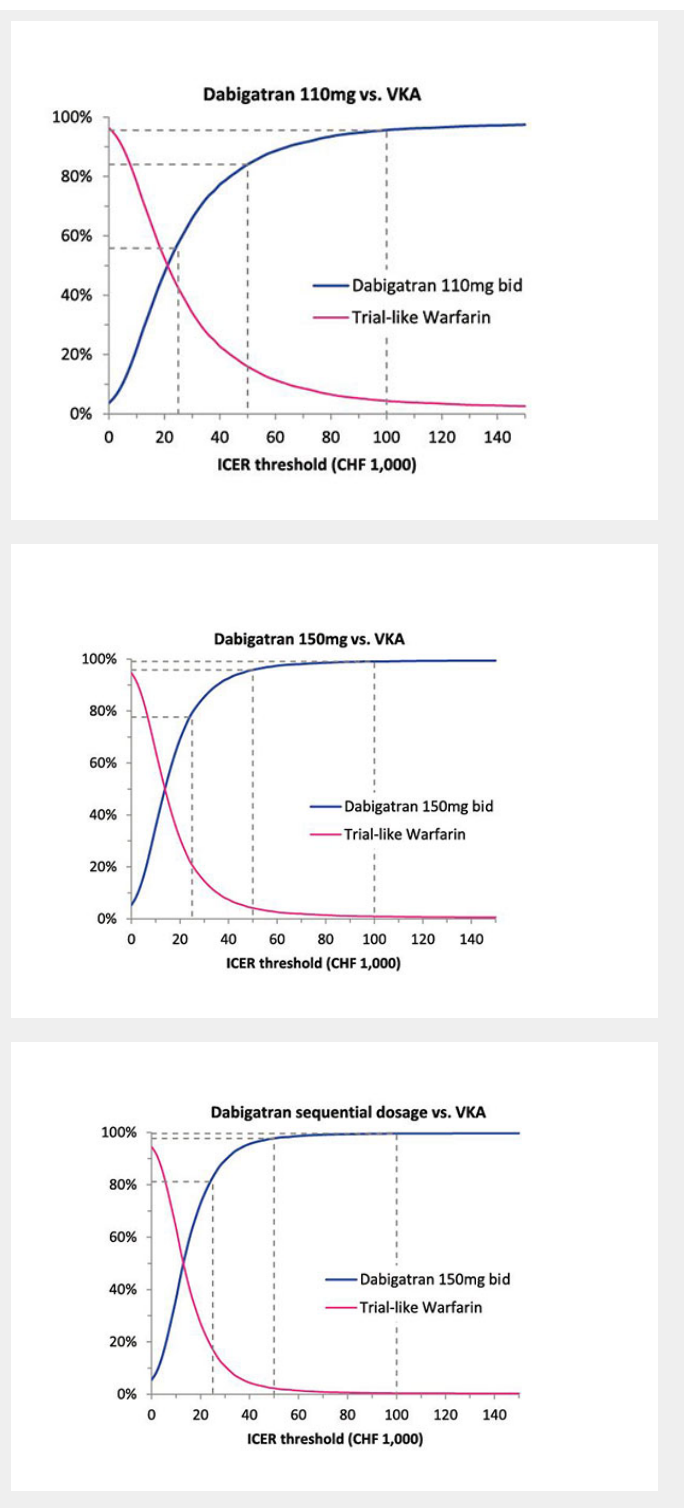
Figure 2 Cost-effectiveness acceptability curves of dabigatran versus VKA in three dabigatran dosage scenarios. The cost-effectiveness acceptability curve (CEAC) of dabigatran shows the probability of dabigatran to be the cost-effective treatment versus the alternative VKA treatment at different ICER thresholds. The CEAC is generated on the basis of 10,000 PSA model runs. A point on the line can be interpreted as the probability to correctly choose dabigatran as the cost-effective drug at a determinate ICER threshold. The dotted lines indicate these probabilities at thresholds of CHF 25,000.‒, CHF 50,000.‒, and CHF